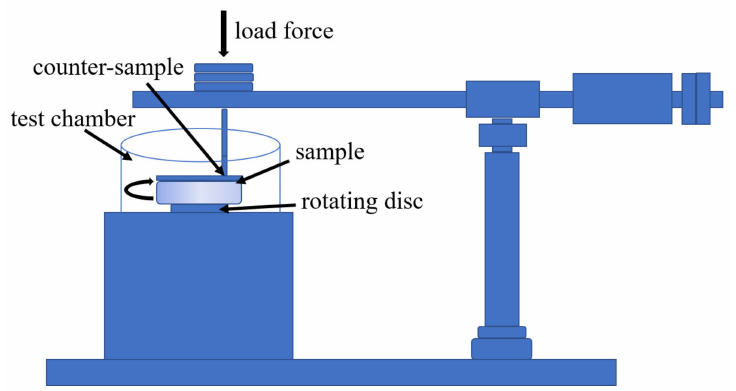
Figure 1. A scheme of the ball-on-disc